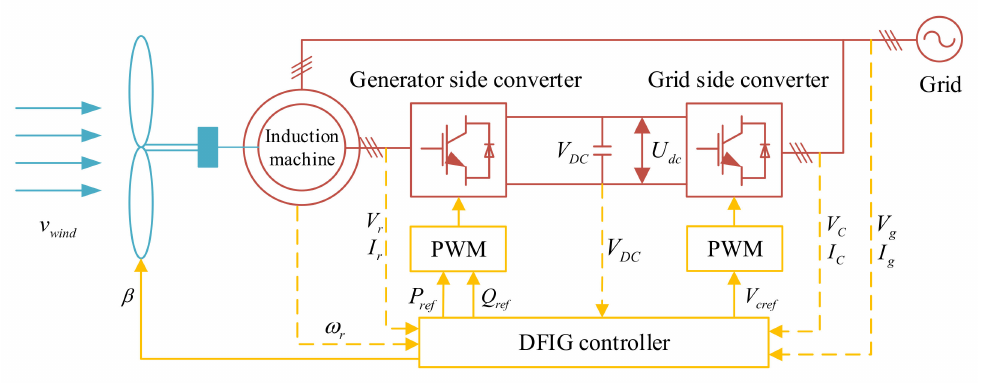
Figure 1. The diagram of DFIG-based wind